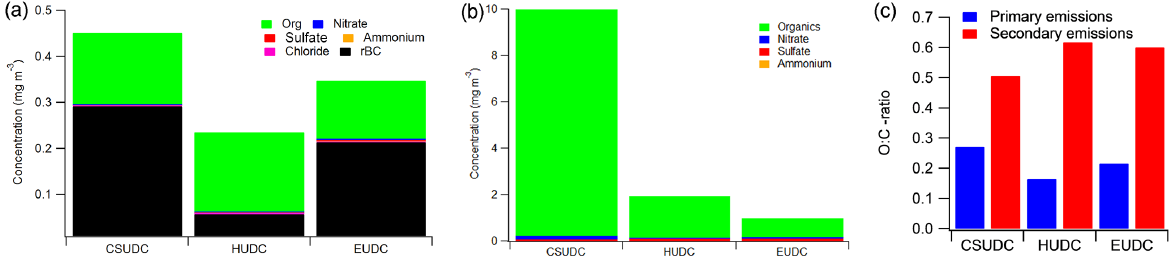
Figure 7. (a) Chemical composition of primary PM, (b) chemical composition secondary PM and (c) the O:C ratios of primary and sec- ondary particulate matter for different parts of the NEDC